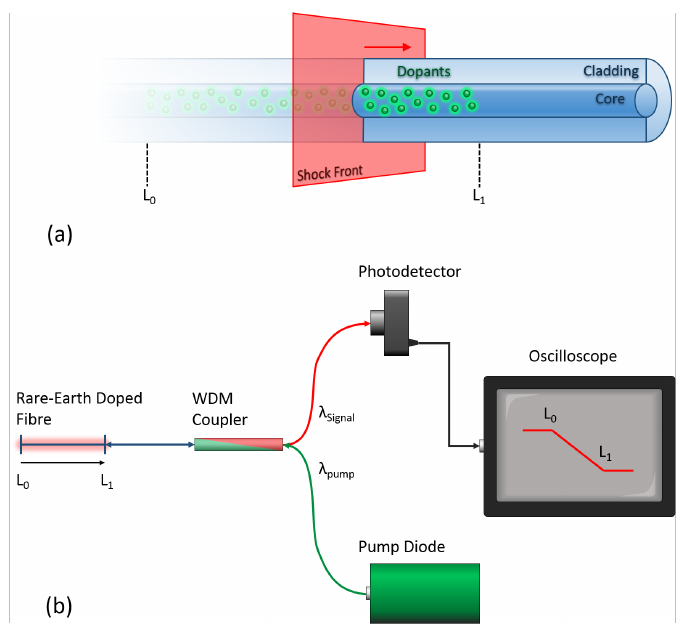
Figure 1. ( a ) An illustration of the active fibre concept—a detonation shock wave destroys the active fibre, reducing the number of fluorescent dopants. ( b ) A schematic showing the basic setup for an active fibre detonation velocity probe. A rare-earth-doped fibre is pumped with a diode laser. The amplified spontaneous emission (ASE) fluorescence is filtered through a wavelength division multiplexing (WDM) coupler and collected on a